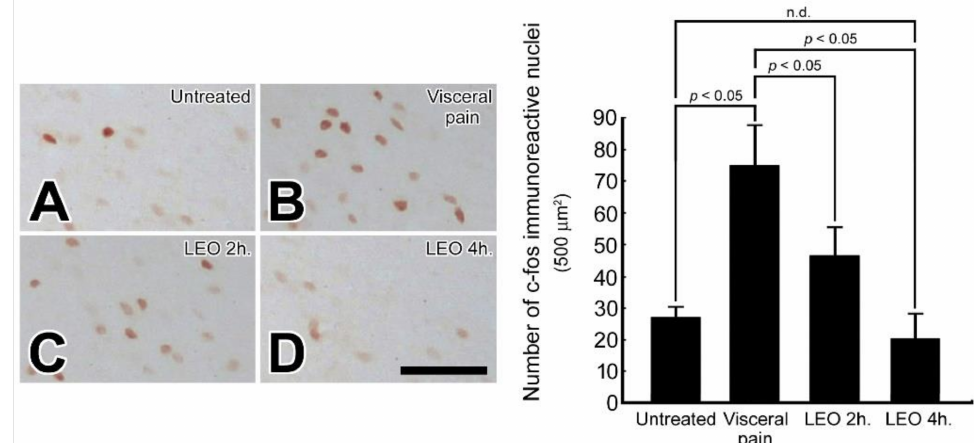
Figure 3. Photomicrographs ( A – D ) and histogram show the c-fos immuno-expression in the CeA of the untreated ( A ), visceral pain ( B ), and OS groups receiving LEO for 2 h ( C ) and 4 h ( D ). Note that in the untreated group, only a small number of c-fos immuno-reactive nuclei was detected in the CeA ( A ). However, following visceral pain, a large number of nuclei in the CeA were positive stained for c-fos immunoreactivity ( B ). Nevertheless, in rats subjected to visceral pain and who received LEO, the expression of c-fos was drastically reduced in which only a few nuclei was positively stained for c-fos ( C , D ). Quantitative evaluation corresponded well with immunohistochemical findings in which LEO inhalation successfully reduced the number of c-fos immuno-expression in the CeA following the induction of visceral pain. n.d. = no significant difference. Scale bar = 25 µ m.